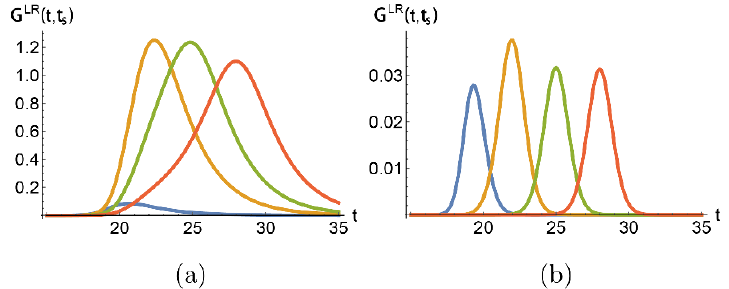
Figure 9 . Plot of G LR ( t; t s ) as a function of t for (cid:12)xed t s . In (a) we choose (cid:1) J = (cid:1) O = 4 = 9, in (b) we enlarge (cid:1) J as (cid:1) J = 3. Blue, yellow, green and red curves are for t s = t (cid:3) +0 : 5 ; t (cid:3) +3 : 5 ; t (cid:3) + 6 : 5 ; t (cid:3) + 9 :